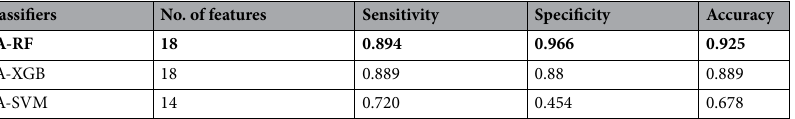
Table 1. Performance evaluations for different machine learning-incorporated genetic algorithm (GA) models on the GBM dataset. RF random forest, XGB XGBoost, SVM support vector machine. Model with the best performance is indicated in bold